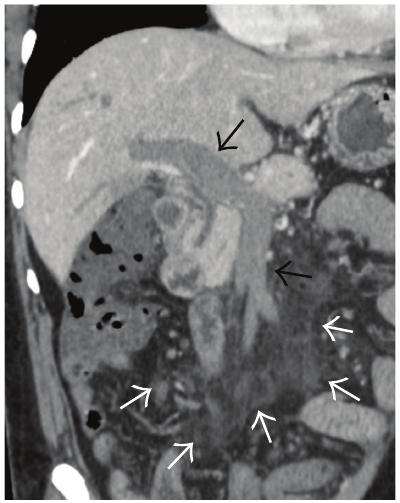
Figure 50: Coronal MIP image showing complete portomesenteric vein thrombosis (black arrows) with associated mesenteric strand- ing (white